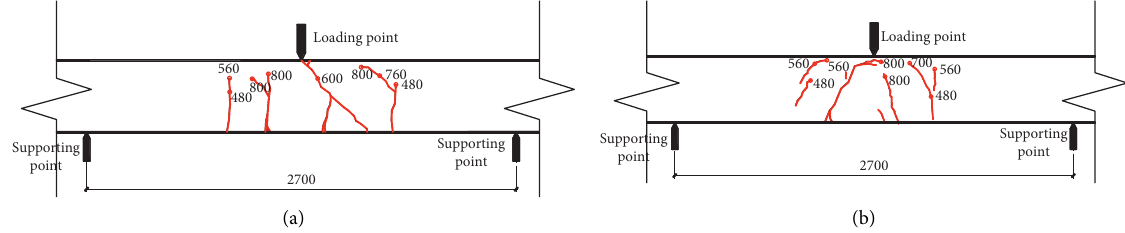
Figure 15: Crack distribution of SC-P3. (a) Crack distribution on Side A and (b) crack distribution on Side B.